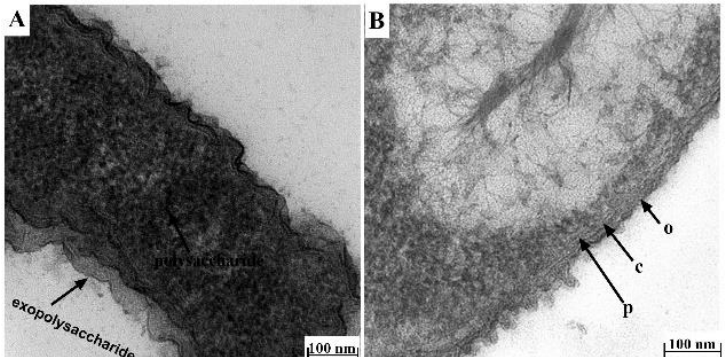
Figure 4. Effect of fixation duration and growth medium on the morphology of Xen41 cells. TEM comparison of Xen41 morphology using cacodylate buffer and fixative containing 4.0% formaldehyde, 1.25% glutaraldehyde, 4% sucrose and 0.01 M CaCl 2 and following different fixation times and growth in different media: ( A ) Xen41 was cultured overnight in LB broth, washed and fixed overnight and then processed according to Procedure 4; ( B ) Xen41 was grown overnight on horse blood agar initially, washed and fixed for 1 h, washed, and fixed again for an additional 1.5 h and then processed according to Procedure